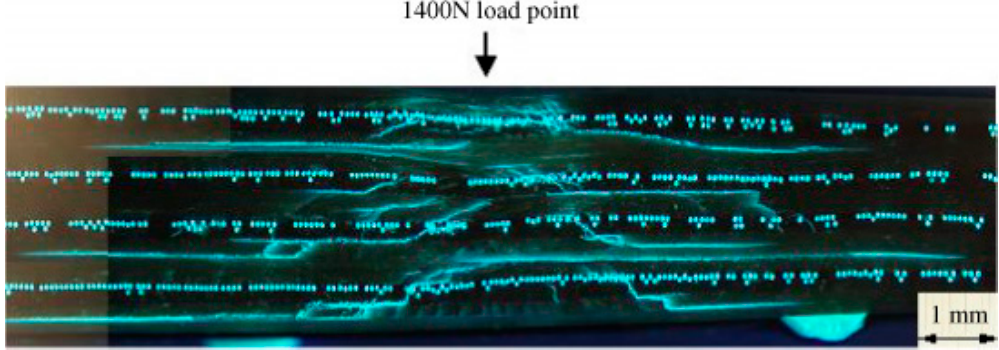
Figure 15. Released ultraviolet (UV)-fluorescent “healing agent” infiltrates the damage zone after flexural strength testing. Reproduced with permission from [81]. Copyright 2006, IOP Publishing Ltd.